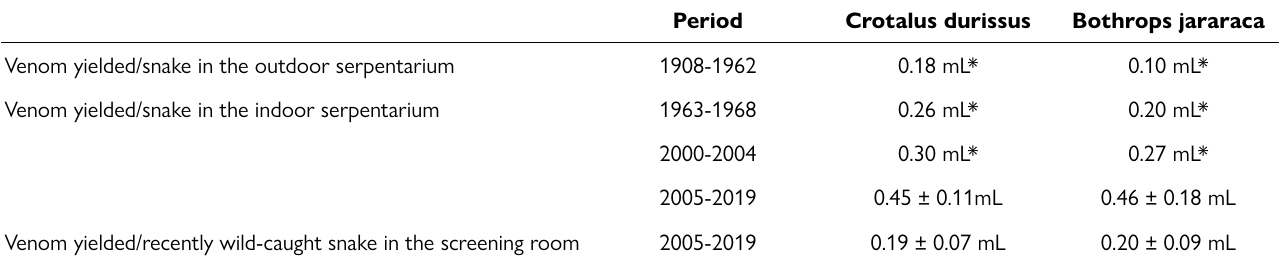
Table 1. Venom yielded per snake [mean volume (mL) ± standard variation], according to the management and year of